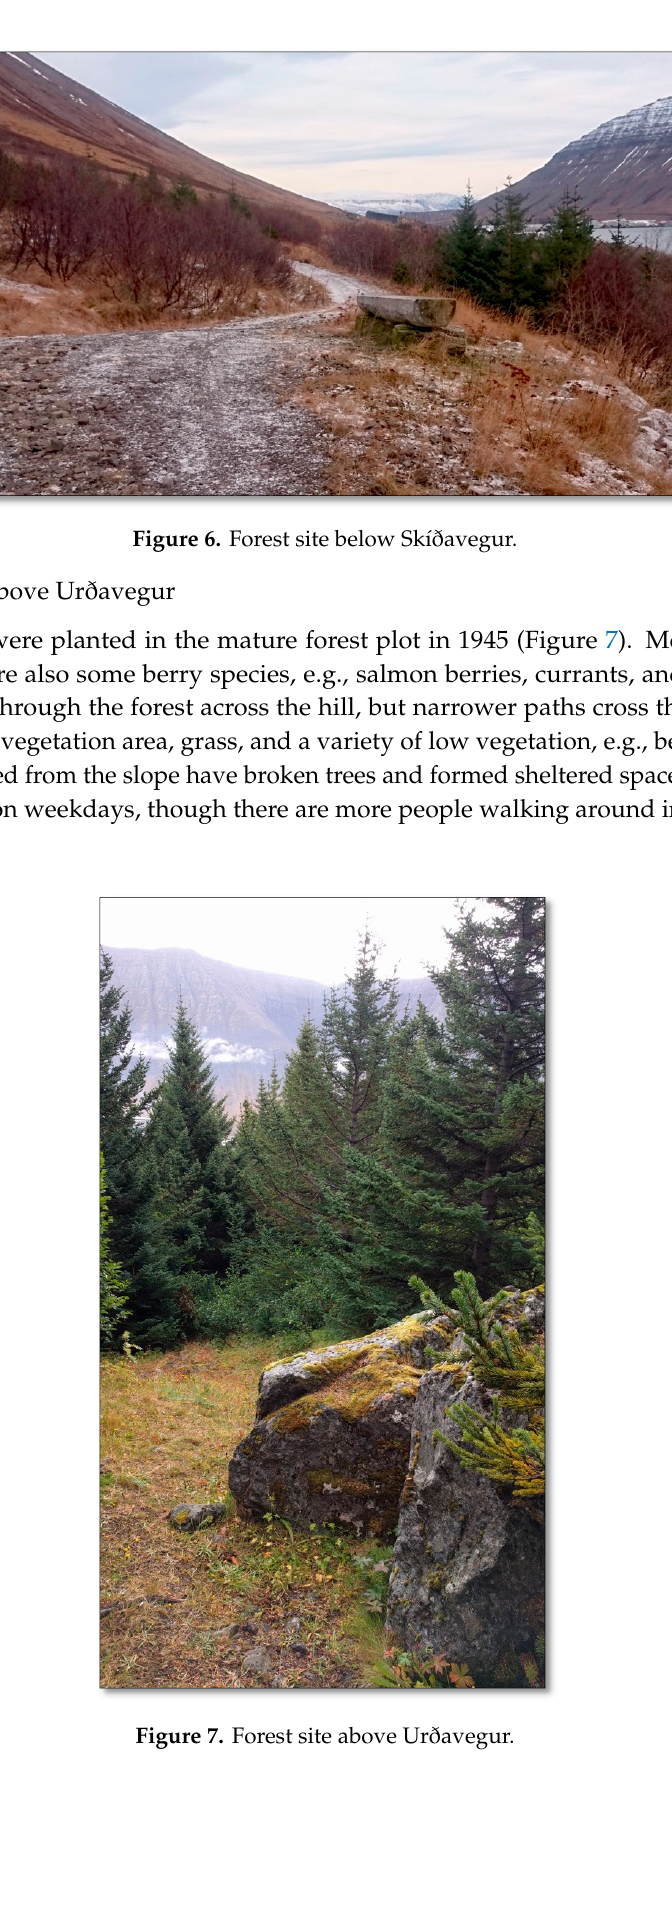
Figure 5. Skeljavík Shore. 2.3.3. Forests Sites Site 5—Forest Site Below Skíðavegur The forest site was planted around 1990 (Figure 6). It is part of a larger outdoor recreation area,